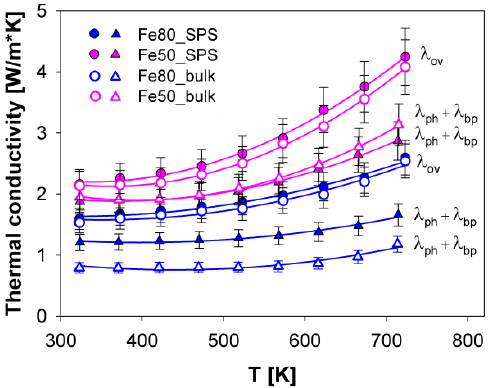
Figure 11. The trend of overall ( λ ov ), and lattice and bipolar ( λ ph + λ bp ) thermal conductivity of the samples Fe80_SPS and Fe50_SPS as a function of the temperature.